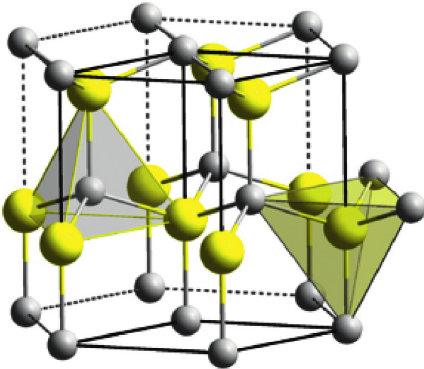
Figure 1: Atomic structure of nano